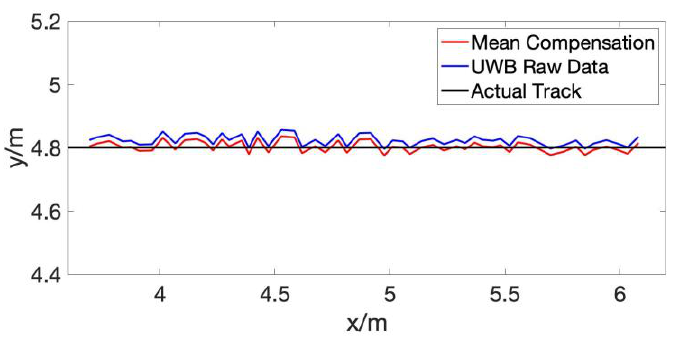
Figure 13. Comparison of corrected data and original data.